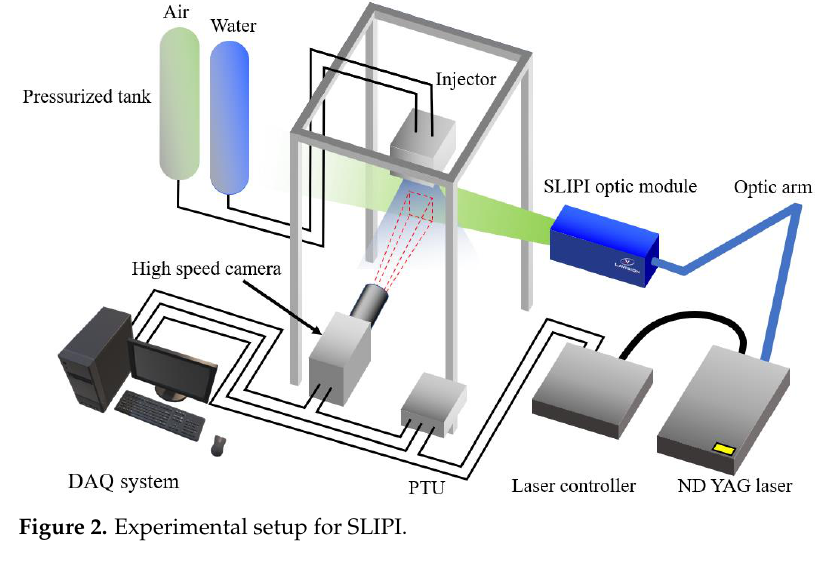
Figure 2. Experimental setup for SLIPI.